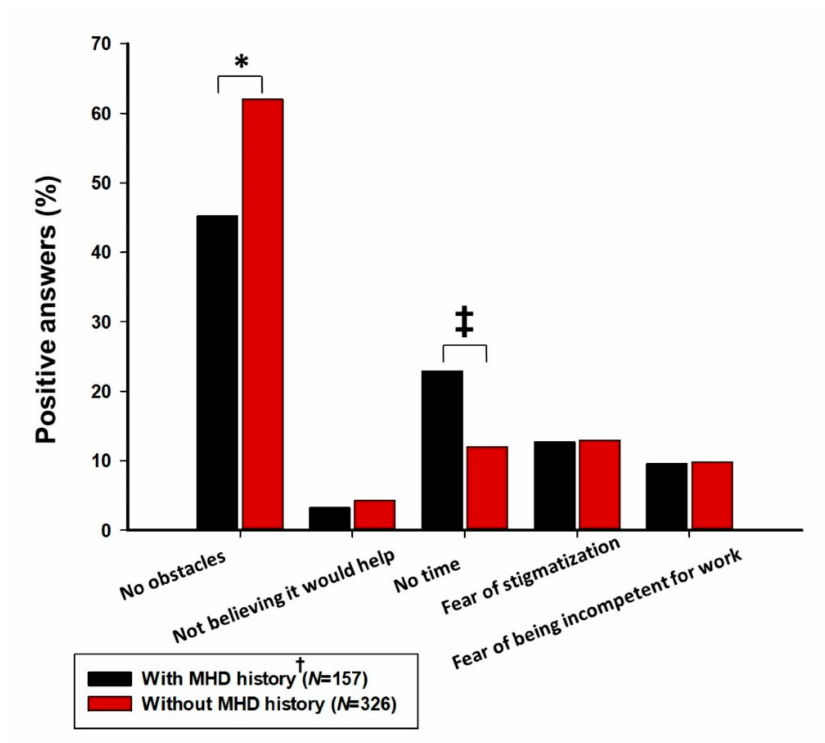
Figure 1. Experiences and attitudes regarding obstacles in seeking help for mental health disturbance according to the history of mental health disorders § ; MHD—mental health disorder; * chi-square test, p < 0.001; ‡ chi-square test, p = 0.002; † confirmed MHD diagnosis or positive subjective perception, § population with MHD history disclosed experiences, while population without MHD history disclosed